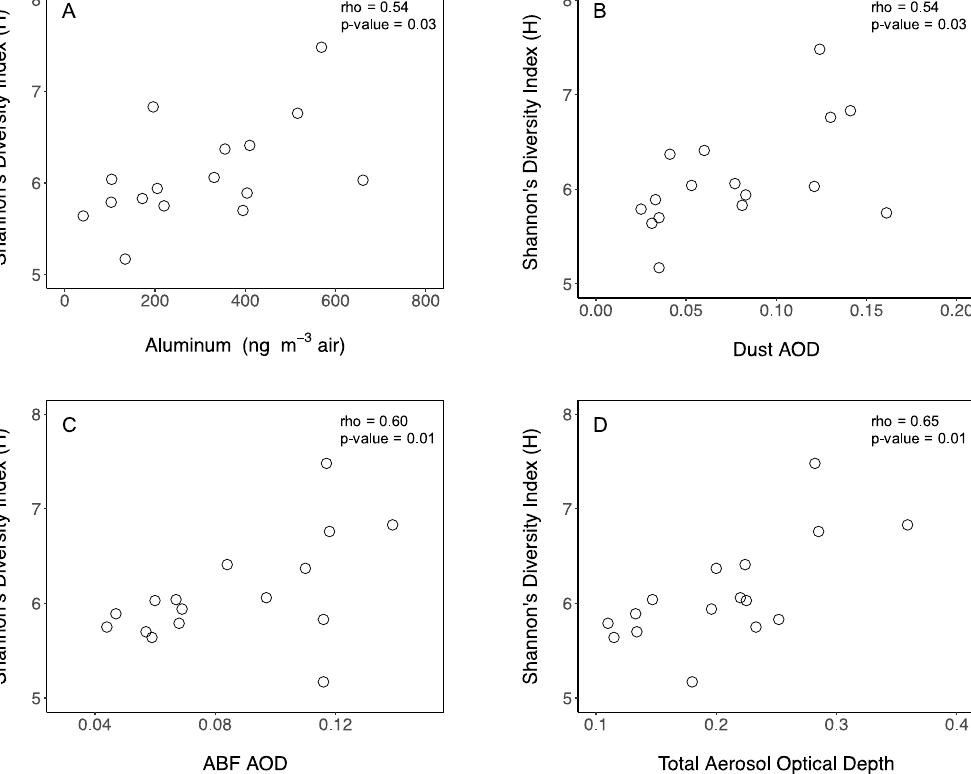
Figure 6. PCoA showing the differences in beta diversity using weighted UniFrac with ( A ) shapes representing regions of the MS samples were collected in, and ( B ) distance (km) between each sample site and closest landmass.